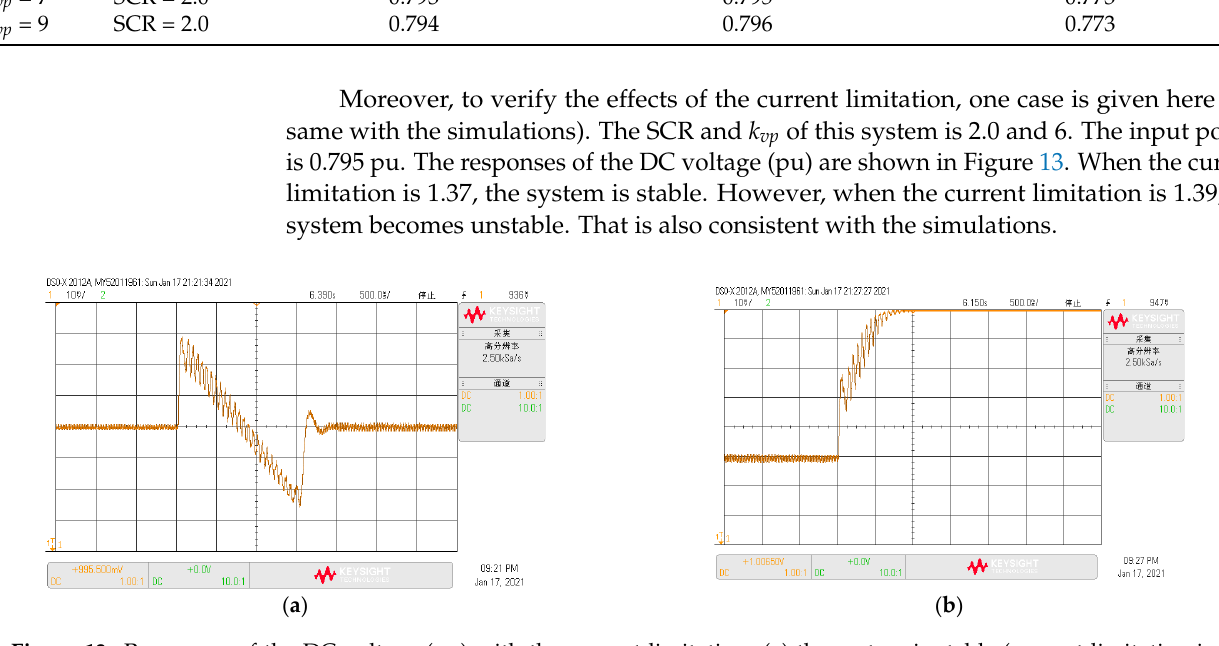
Table 3. Experimental Results, Simulation Results and the Theoretical Results.